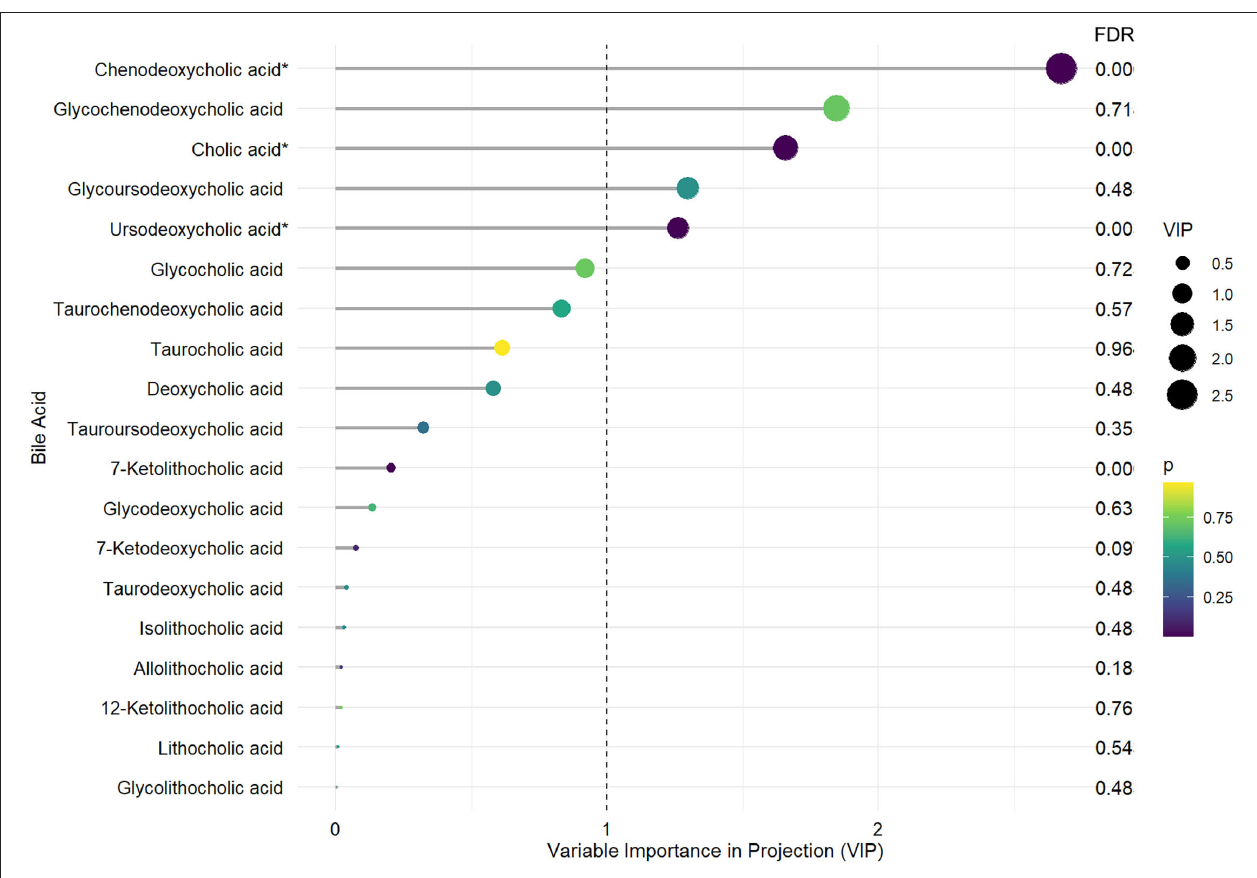
FIGURE 1 | The distinct bile acid profile in PD-MCI compared to patients with PD-NC. The length of the lines and the size of the dots represent the value of variable importance in projection (VIP); the longer the lines and larger the dots, the larger the VIP value. The color of the dots represents the FDR-corrected p -value; the purple the color, the lower the p -value, and the yellower the color, the larger the p -value. * Differential BA metabolites with VIP > 1. and FDR-corrected p -values <